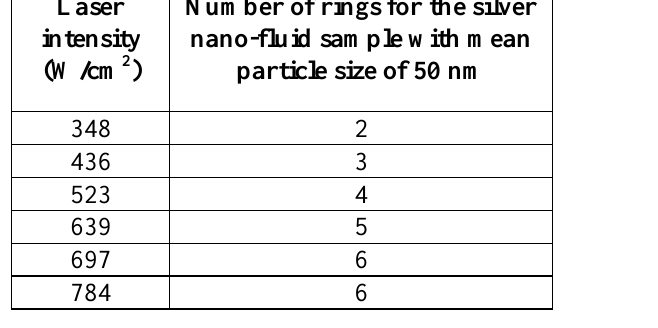
Table 1: Illustrates the number of diffraction rings formed by the prepared silver nanoparticles in DI in the presence of TSC as a stabilizer at different laser intensities.